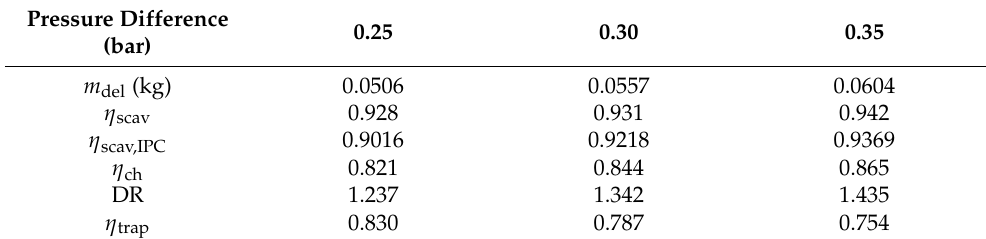
Table 7. Scavenging parameters for different pressure differences.